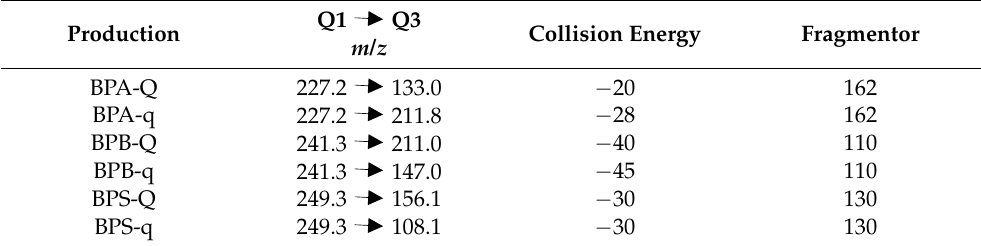
Table 2. UHPLC-MS/MS Quantifier and Qualifier transitions, Collision energy and Fragmentor used for BPA, BPB and BPS.